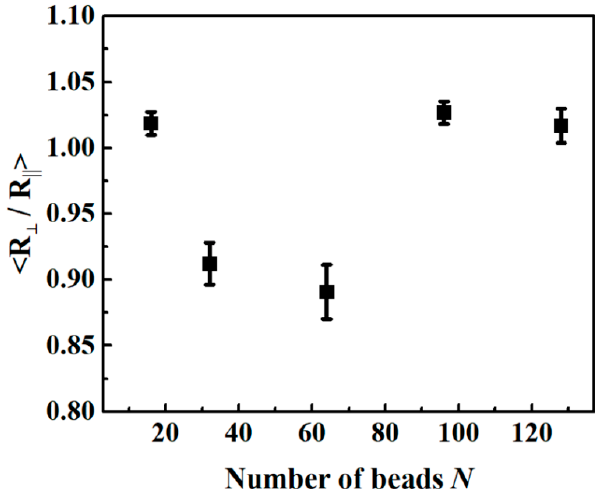
Figure 5. Average ratio of the R ⊥ to the R ∥ in the interface region after PEB as a function of the number of beads N .